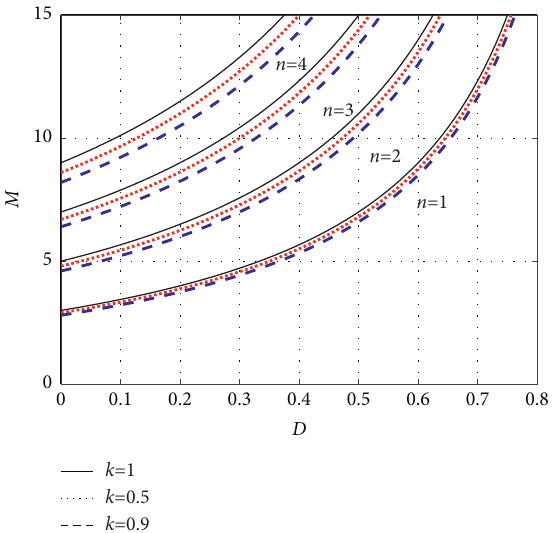
Figure 6: Voltage gain of the converter and the coupled coefficient k and turns ratio n